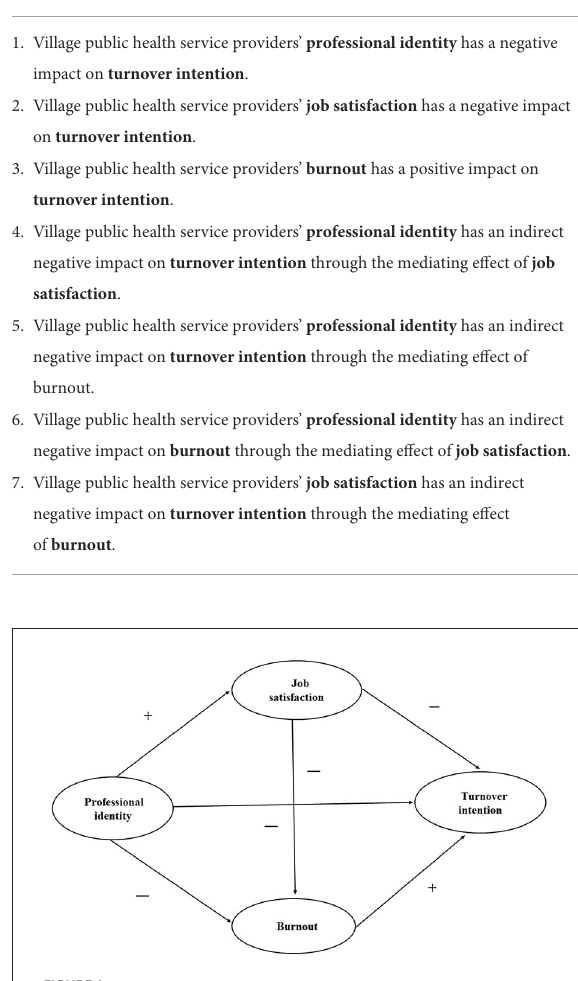
FIGURE1 The theoretical model and